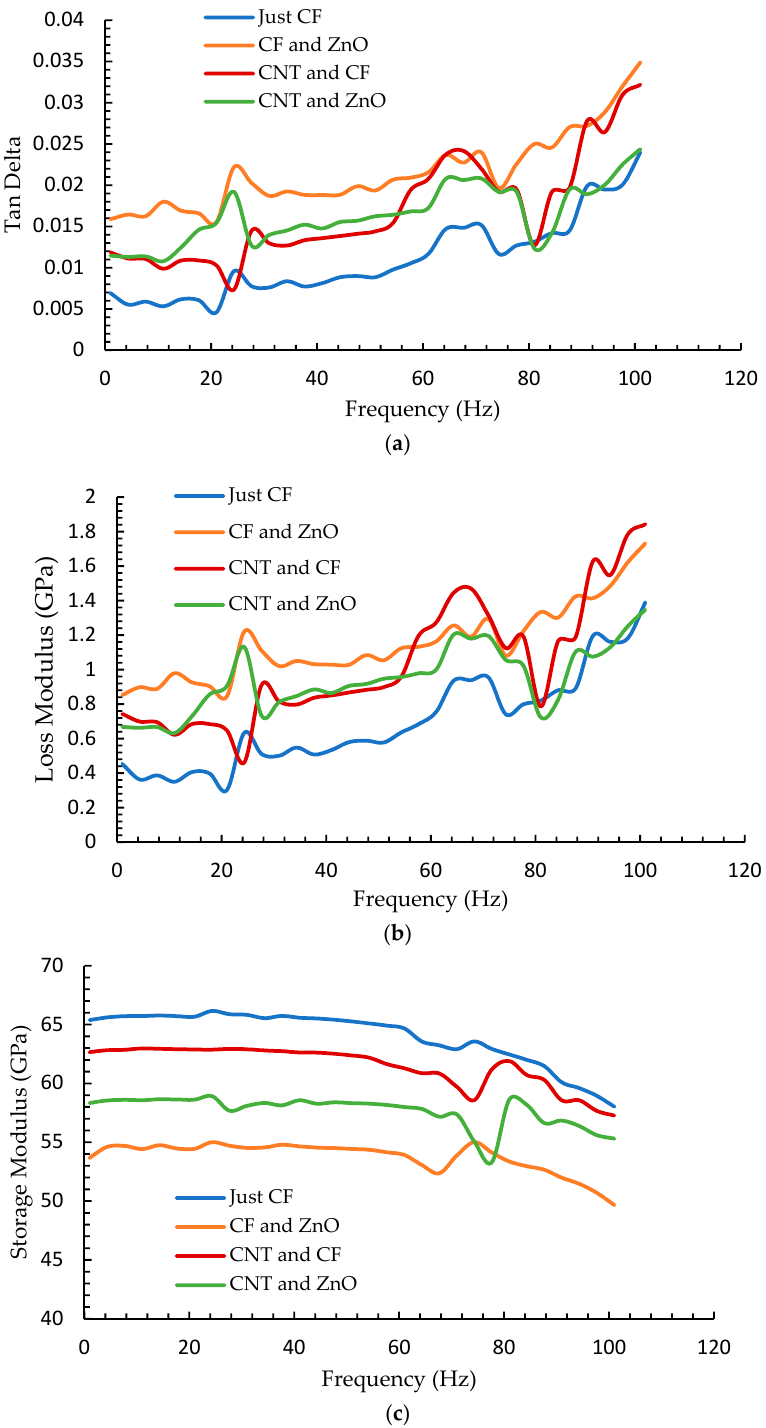
Figure 3. The viscoelastic properties evolution of the different composites in frequency sweep analysis at 30 °C. (a) Tan delta, (b) Loss modulus, and (c) Storage modulus.